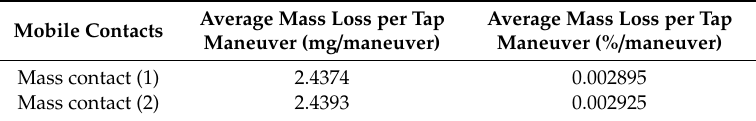
Table 7. Average loss of mass of the moving contacts by tap